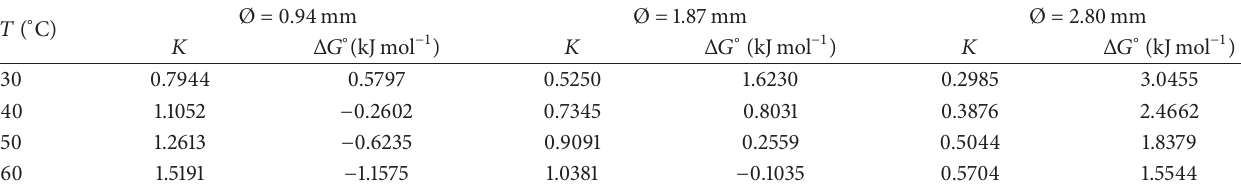
Table 5: Equilibrium constant ( 𝐾 ) and variation of Gibbs free energy ( Δ𝐺 ∘ ) for the oil extraction process from Jatropha seeds with moisture content of 0% for different temperatures and particle sizes using ethanol as a solvent.